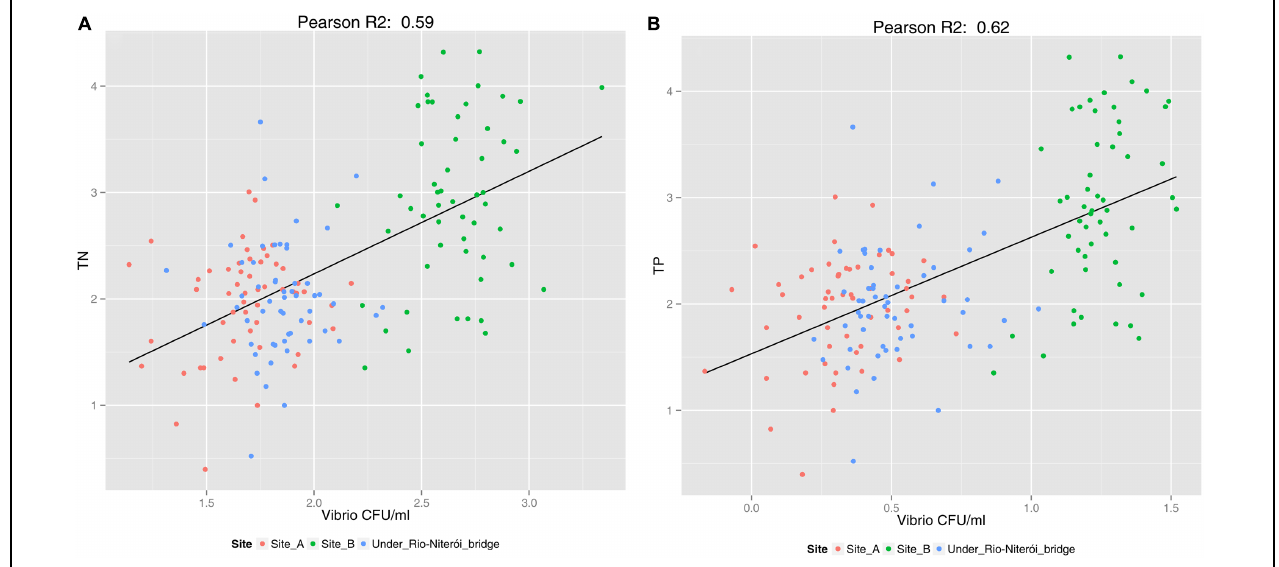
FIGURE 5 | Scatterplot showing the correlation between the abundance of vibrios (CFU ml − 1 ) and concentrations of total nitrogen (log10 µ M) (A), which had a correlation of R 2 = 0.59, and total phosphorus (log10 µ M) (B), which had a correlation of R 2 = 0.62, for three sites of Guanabara Bay across a 6-years’ time-series (adapted from Gregoracci et al., 2012). For site location see Figure 3 . Besides the correlation between vibrio abundance and nutrient concentration, the figure shows a clear separation between the less impacted sites “A” and “under Rio-Niteroi Bridge”, and the more impacted site